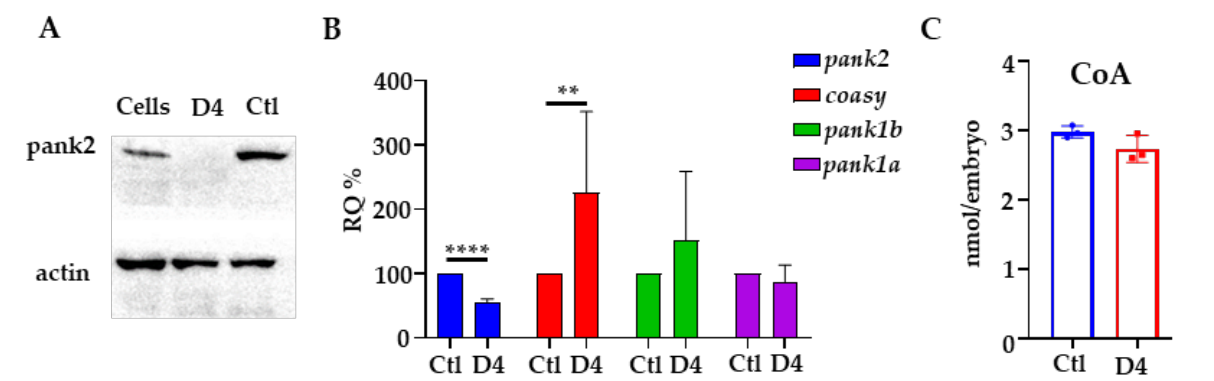
Figure 1. Molecular characterization of D4 mutant embryos. ( A ) Western blot for Pank2 in mutant (D4) and control embryos (Ctl). Lysates from SH-SY5Y cells (Cells) were run as controls. ( B ) qPCR analysis on mutant and control embryos for pank2 , coasy , pank1a, and pank1b . ( C ) Coenzyme A quantification by a fluorimetric assay. Data derived from the analysis of 20 embryos/group, with two biological replicates for Western blotting and at least three for qPCR and CoA quantification. ** p < 0.01; **** p < 0.0001, Student’s t -test.